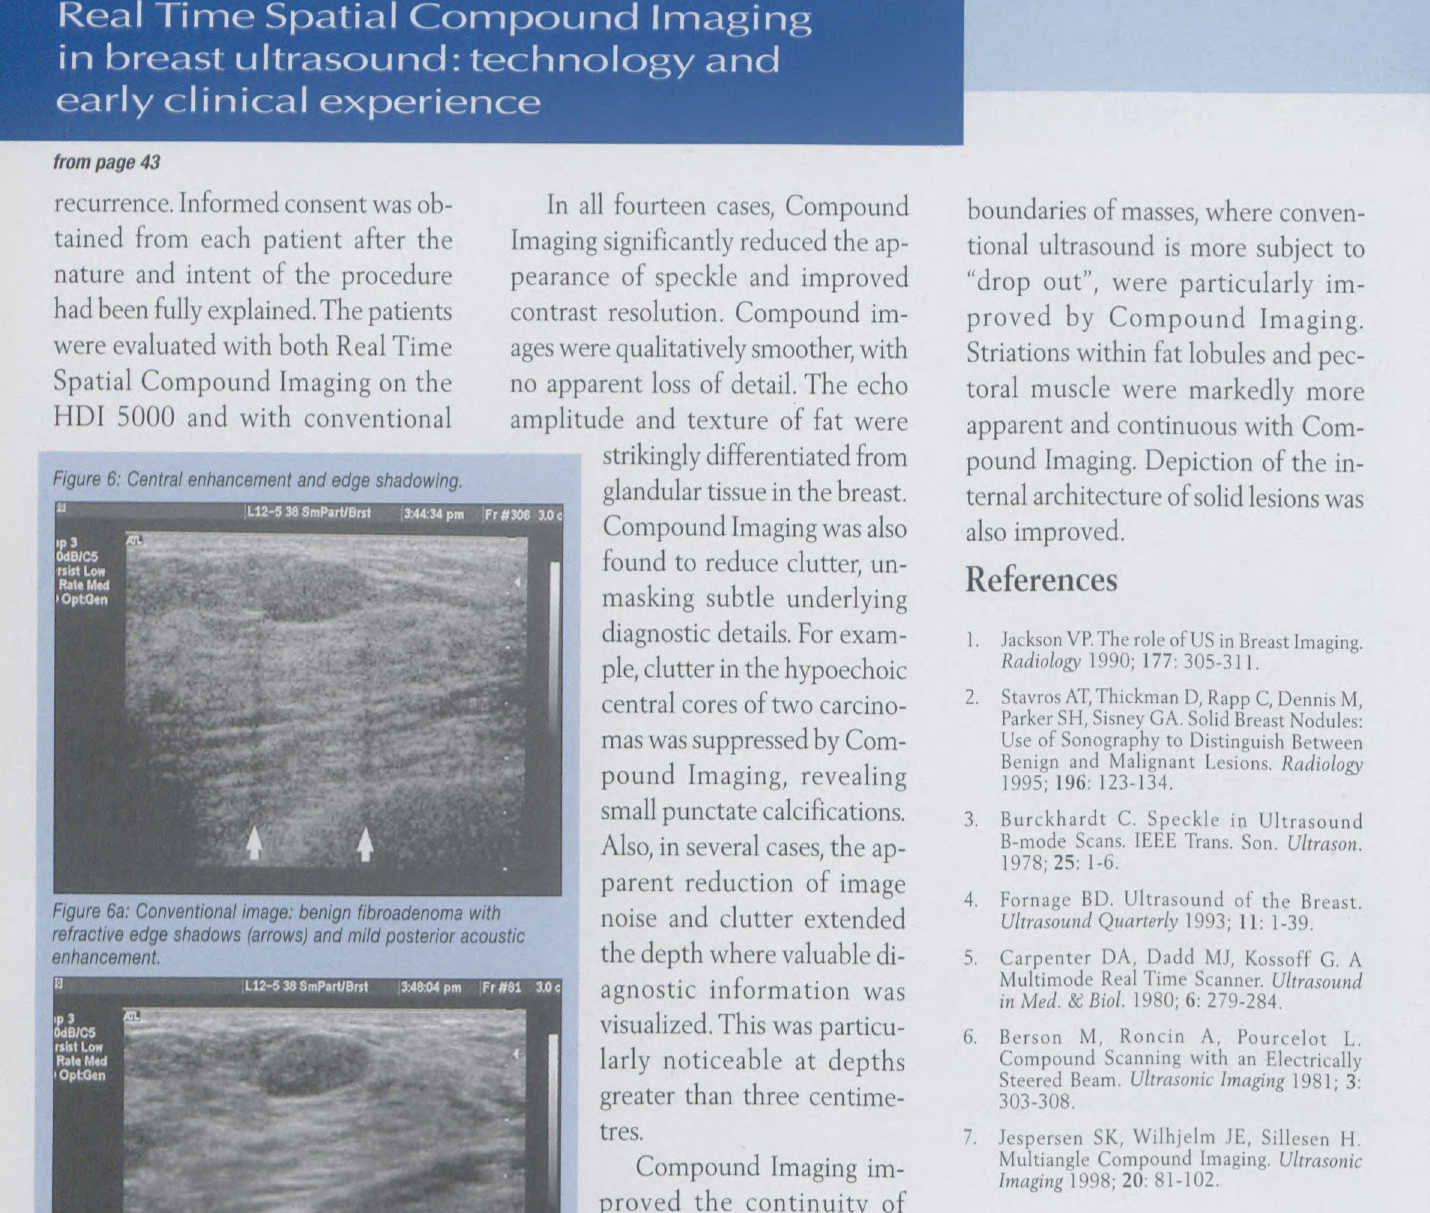
Figure 6b: Compound image: acoustic enhancement is preserved and appears somewhat triangular, as predicted in Figure Sb. Also note suppression of refractive edge shadows, improved portrayal of internal architecture, and better delinea- tion of the fibrous capsule around the